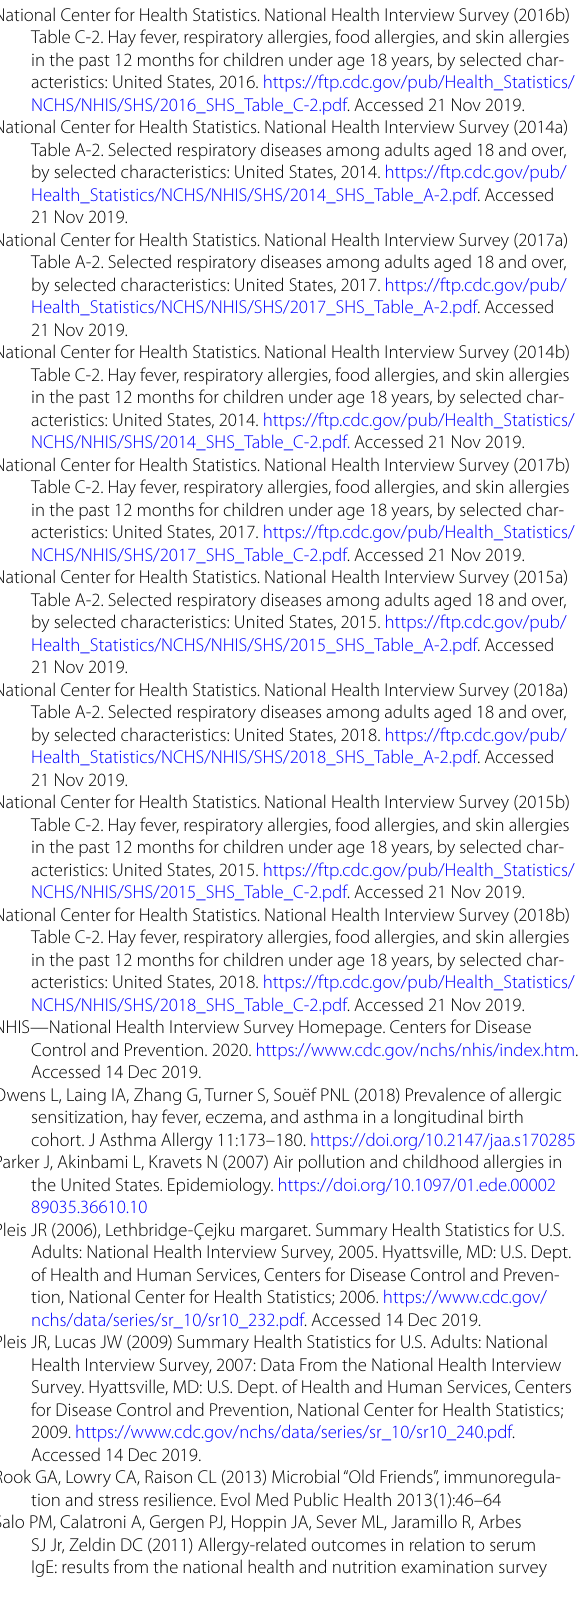
Table C-2. Hay fever, respiratory allergies, food allergies, and skin allergies in the past 12 months for children under age 18 years, by selected char- acteristics: United States, 2014. https:// ftp. cdc. gov/ pub/ Health_ Stati stics/ NCHS/ NHIS/ SHS/ 2014_ SHS_ Table_C- 2. pdf. Accessed 21 Nov 2019.